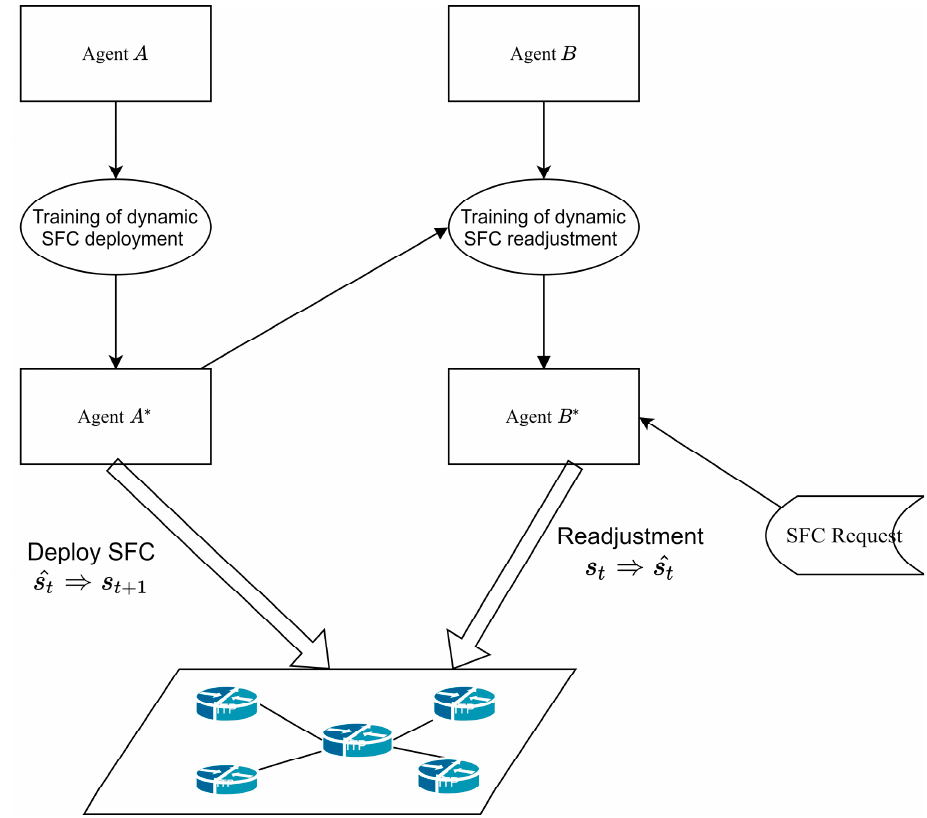
Figure 4. The framework of MQDR.